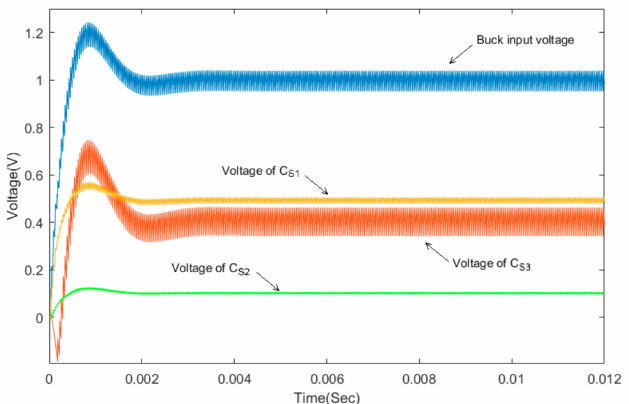
Figure 18. Input voltage of SIMO buck converter in terms of input filter capacitors.